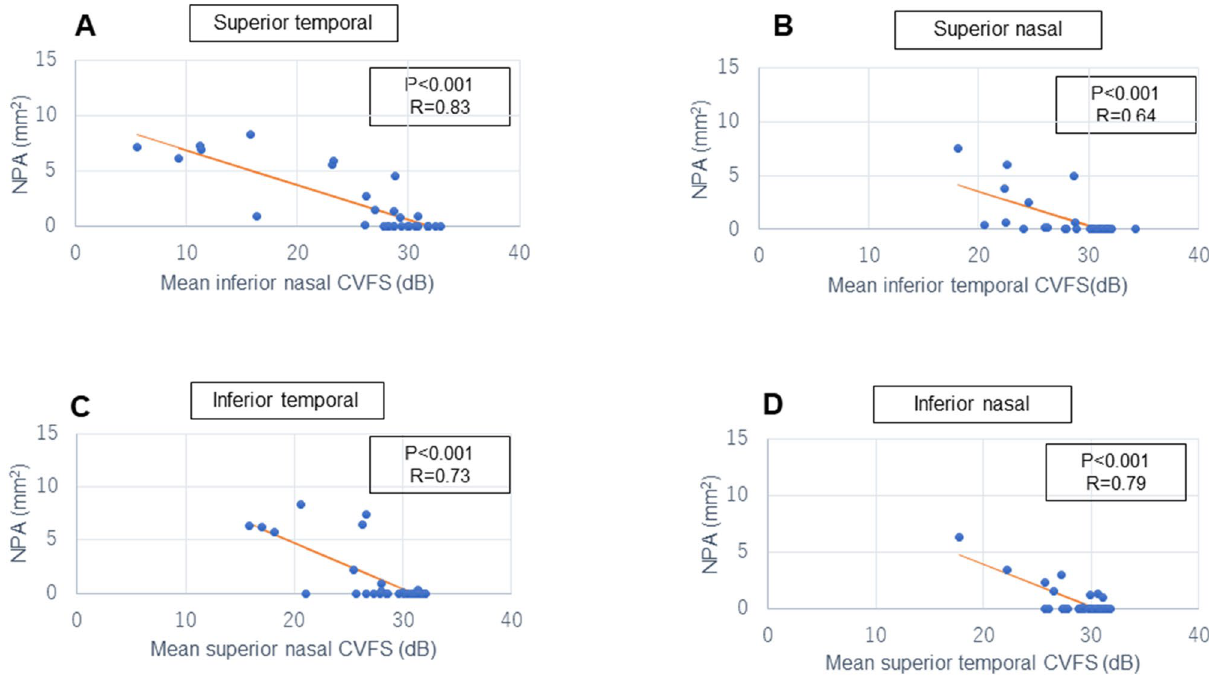
Figure 1. Scatter plots of the correlation between macular m-NPAs on OCT angiography in the SCP and corresponding CVFS values on HFA 10-2. ( A ) m-NPA in the superior temporal region and mean inferior nasal CVFS ( B ) m-NPA in the superior nasal region and mean inferior temporal CVFS ( C ) m-NPA in the inferior temporal region and mean superior nasal CVFS ( D ) m-NPA in the inferior nasal region and mean superior temporal CVFS. m-NPA macular non-perfused areas, OCT optical coherence tomography, SCP superficial capillary plexus, HFA 10-2 Humphrey visual field analyser 10-2 programme, CVFS central visual field